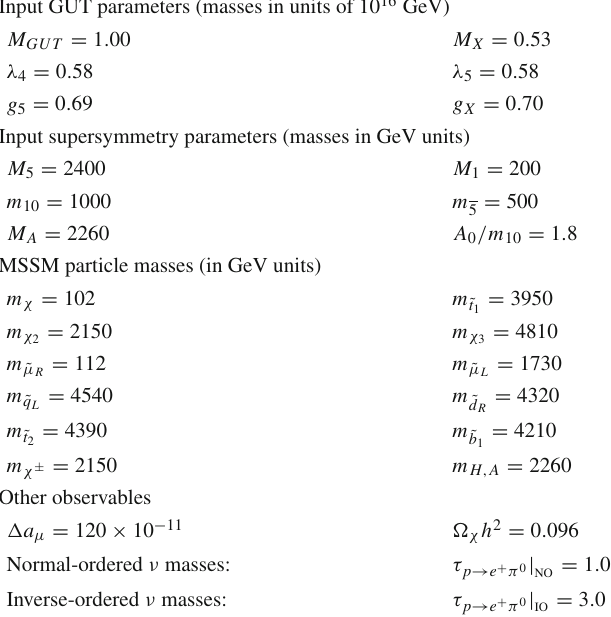
Table 1 Parameters and predictions of an FSU(5) point in the ‘quadri- fecta’ region that yields (cid:12) a μ = 120 × 10 − 11 , values of (cid:17) χ h 2 and m h that are consistent with experiment within theoretical uncertainties, and Input GUT parameters (masses in units of 10 16